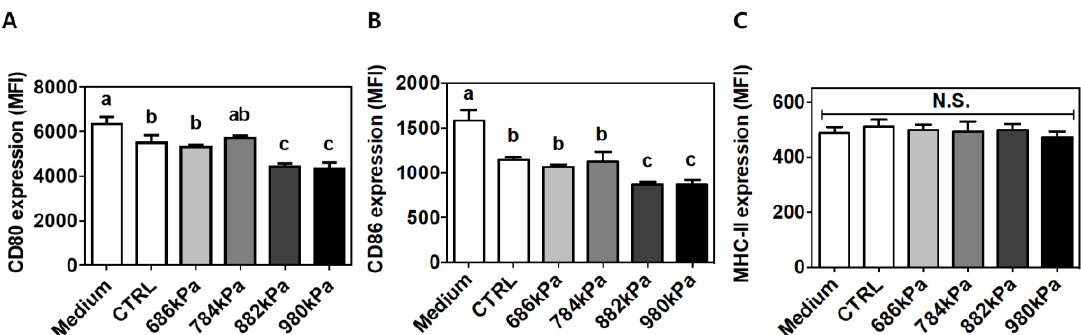
Figure 5. Regulation of activation-marker expression on RAW264.7 macrophages following treatment with puffed turmeric extracts. The expression of CD80 ( A ), CD86 ( B ), and MHC-II ( C ) was quantitatively assessed using staining with fluorescently labeled specific antibody followed by flow cytometry. Means with different letters (a–c) were statistically significant at p < 0.05 within the panel ( n = 4). MFI—mean fluorescence intensity; N.S.—not significant.